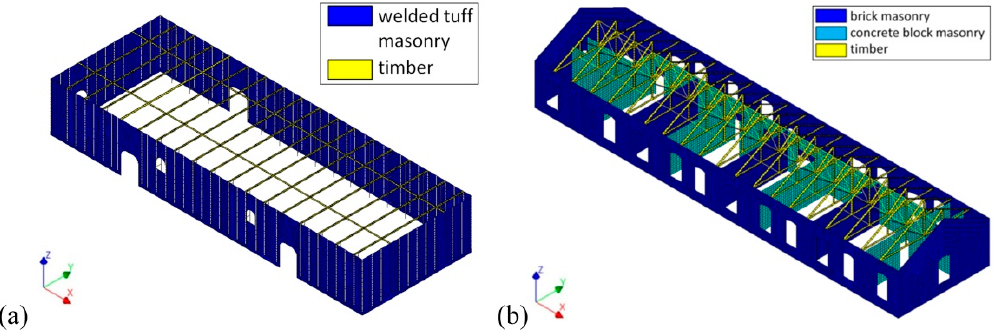
Figure 9. Numerical models: ( a ) the Otaru warehouse and ( b ) the Matsumoto storehouse. Table 2. Material properties adopted to the numerical models.